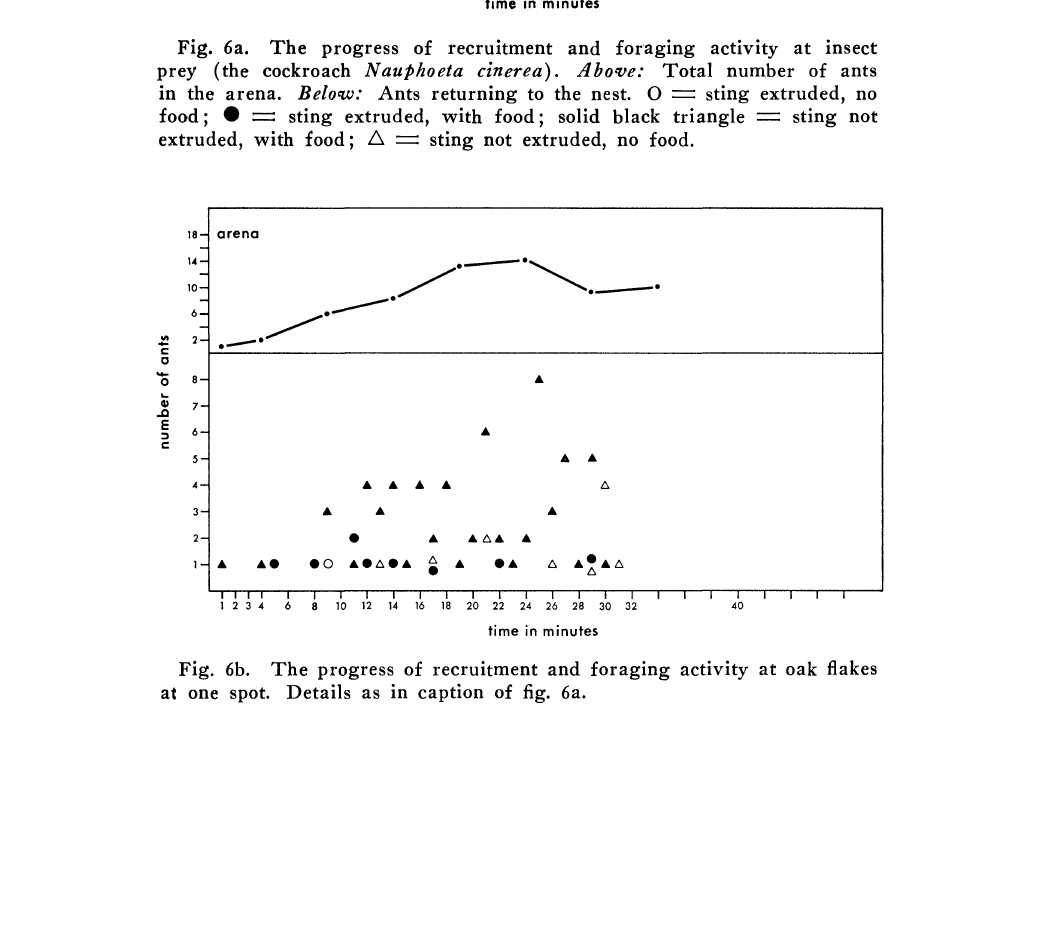
Fig. 6a. The progress of recruitment and foraging activity at insect prey (the cockroach Nauhoeta cinerea). Above: Total number of ants in the arena. Belocv: Ants returning to the nest. O